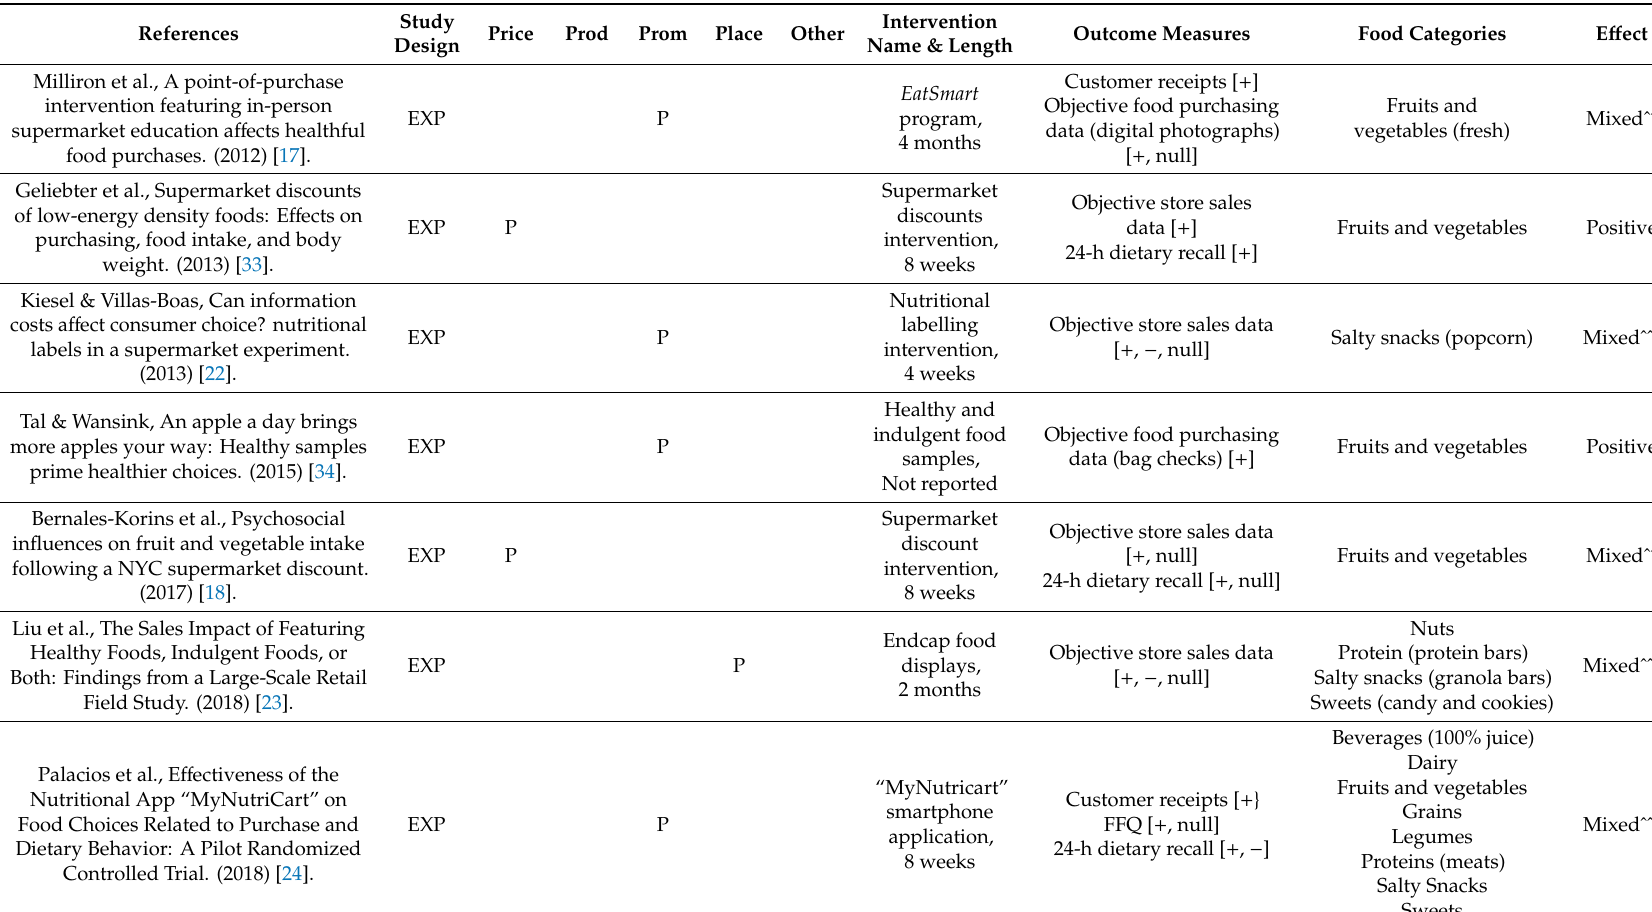
Table 2. Summary of included single-component interventions: Design, focus, and e ff